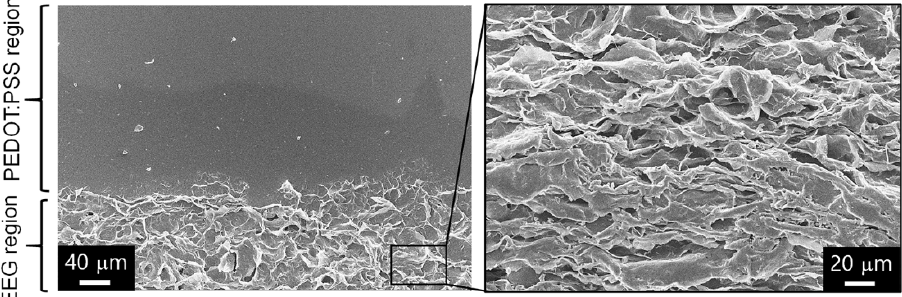
Figure 4. Magnified SEM images of the area where the PEDOT:PSS electrode and the EEG electrode were in contact.